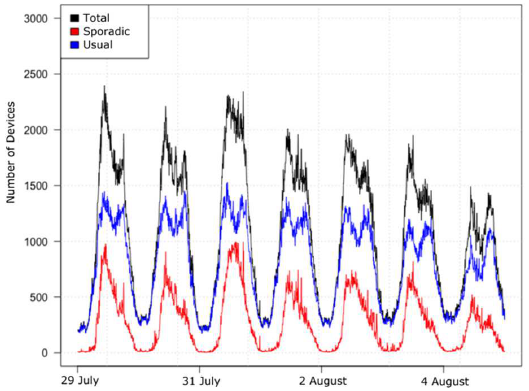
Figure 5. Temporal distribution by device type, from 29 July to 4 August.